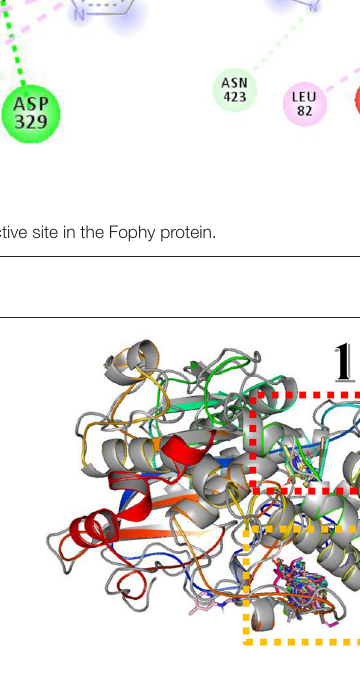
FIGURE 13 | Structure alignment of Blind docking/virtual screening results on Aspergillus niger phytase protein and